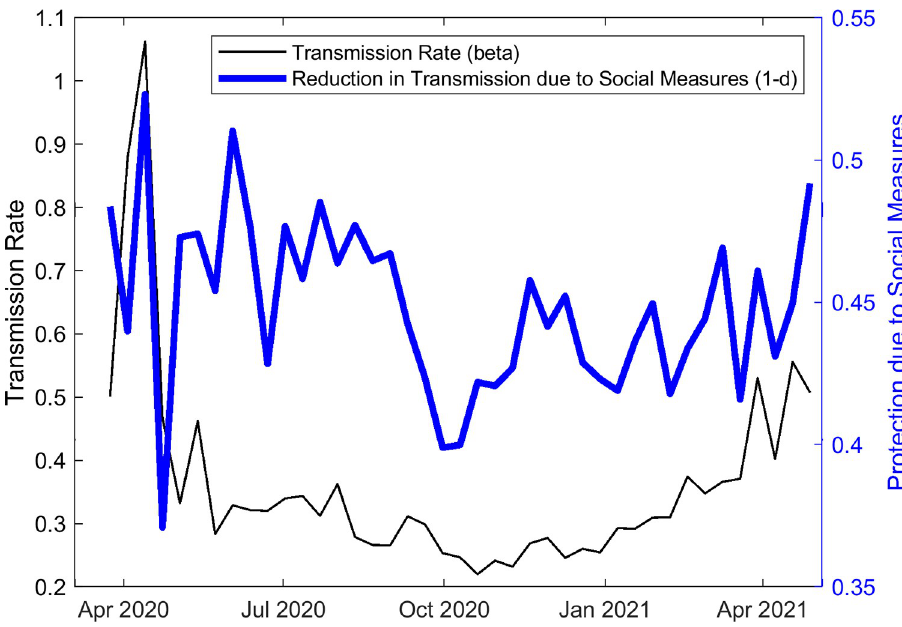
Fig 3. Model estimations of the median transmission rate ( beta ) and the social distancing parameter (1- d ) over time.